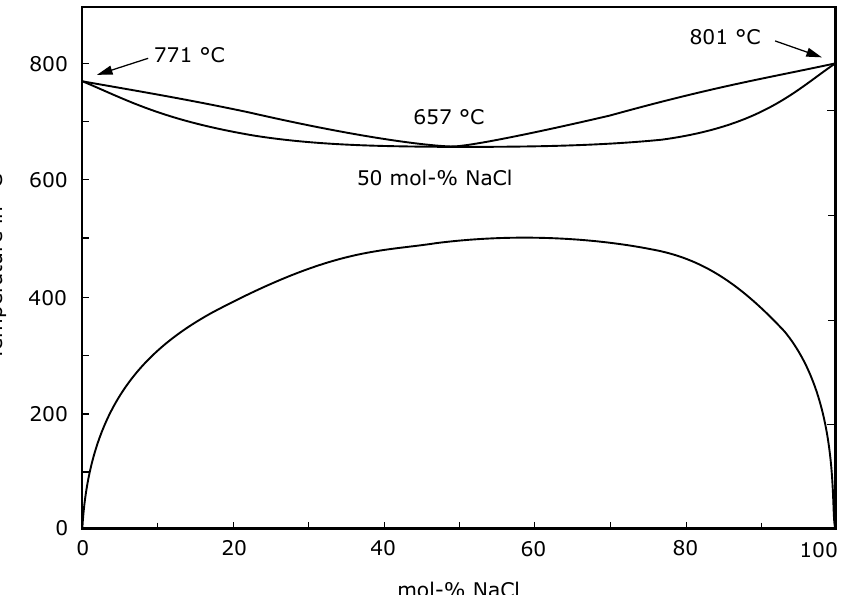
Figure 1. Phase diagram of KCl and NaCl according to Bale et al. [20]. The melting temperature of the eutectic mixture is 657°C. There is a solid solution miscibility gap up to temperatures of approximately 500°C